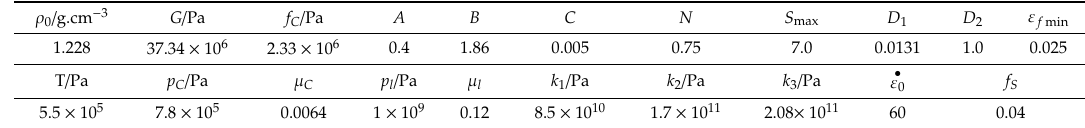
Table 8. Coal HJC constitutive model parameter